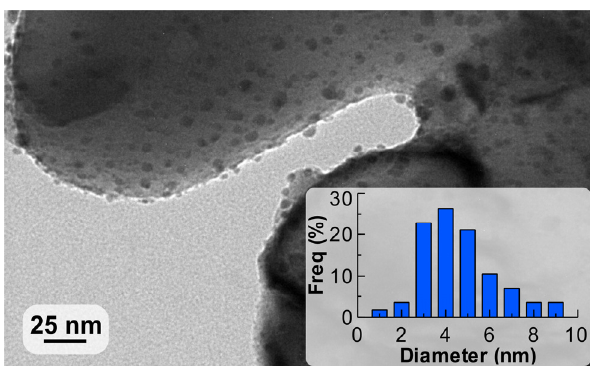
Figure 3. Transmission electron microscopy (TEM) image of the Pd nanoparticles supported on ZnO with their diameter distribution.